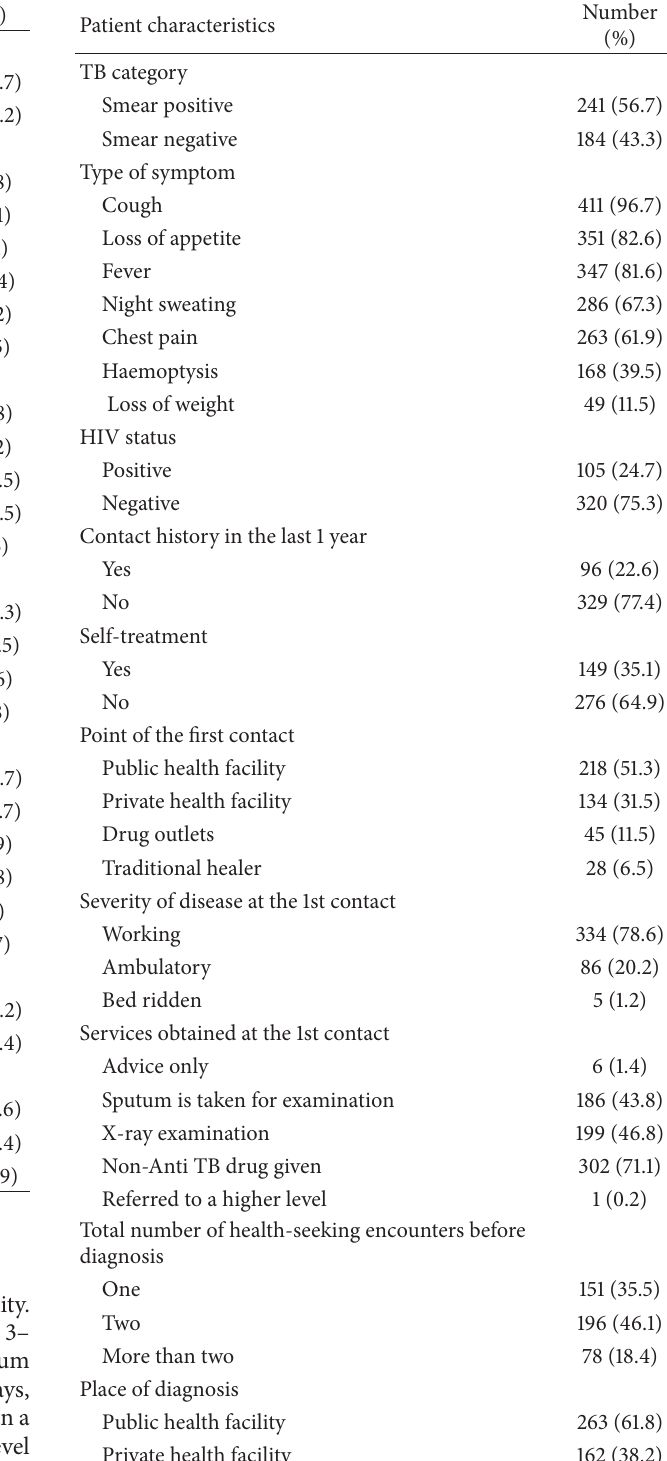
Table 2: Clinical characteristics and health seeking behavior pul- monary TB patients in Addis Ababa, Ethiopia,